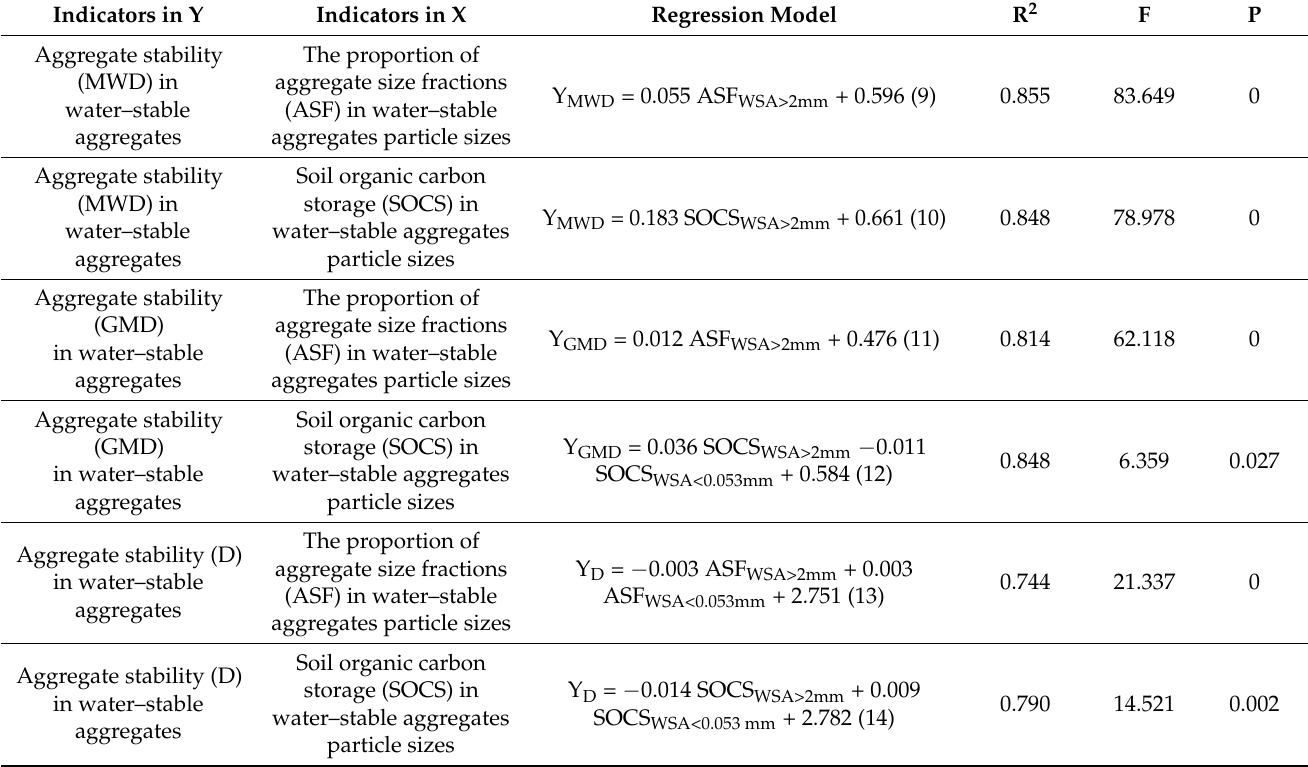
Table 6. Correlations among each measured soil